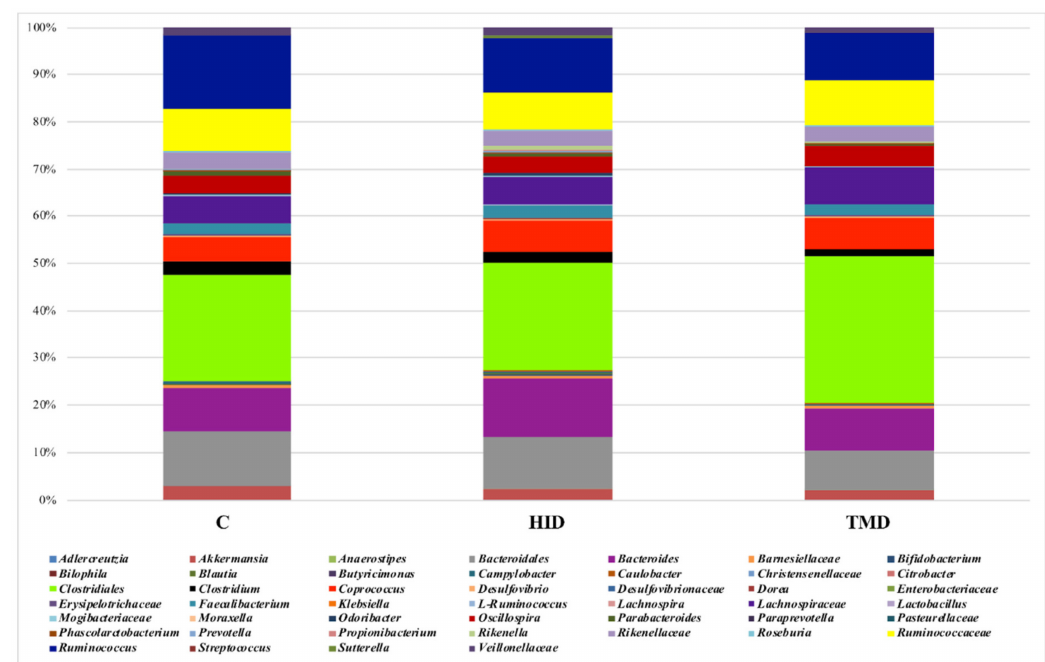
Figure 4. Taxonomic groups detected in cecal samples by means of 16S amplicon target sequencing. Only operational taxonomic units (OTUs) with an incidence above 0.2% in at least two samples are shown. The samples are labelled according to the type of fat supplementation, i.e., TMD, HID, or C diets; C: control diet with soybean oil; HID: diet with Hermetia illucens fat; TMD: diet with Tenebrio molitor fat.